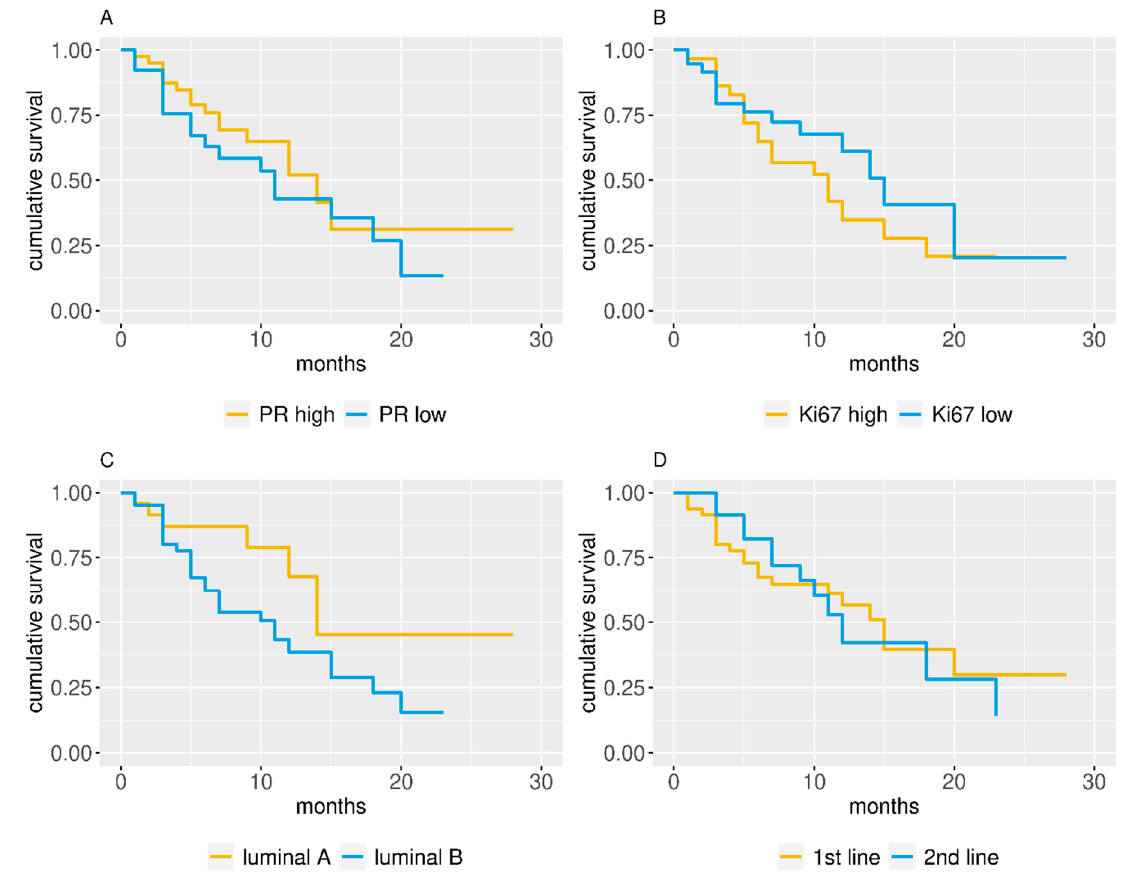
Figure 1. Kaplan–Meier estimated progression-free survival (PFS) curves for ( A ) progesterone receptor (PR) dichotomic value, ( B ) Ki67 dichotomic value, ( C ) cancer subtype, and ( D ) line of treatment.